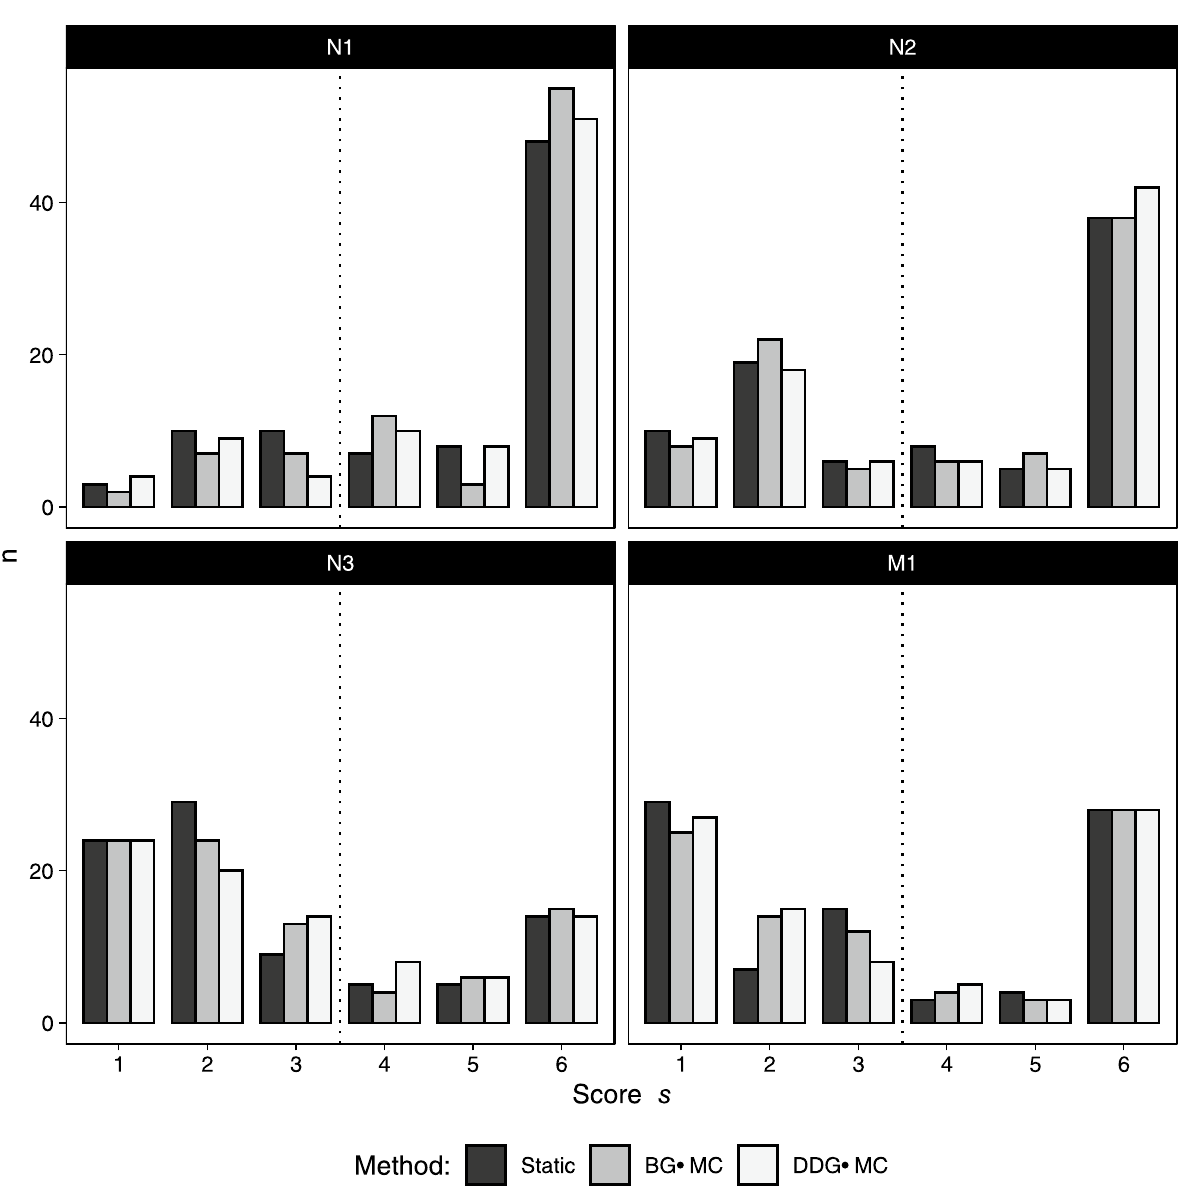
Fig. 2 Distribution of score s for N1 to N3 and M1 by image reconstruction method summed for both readers (N